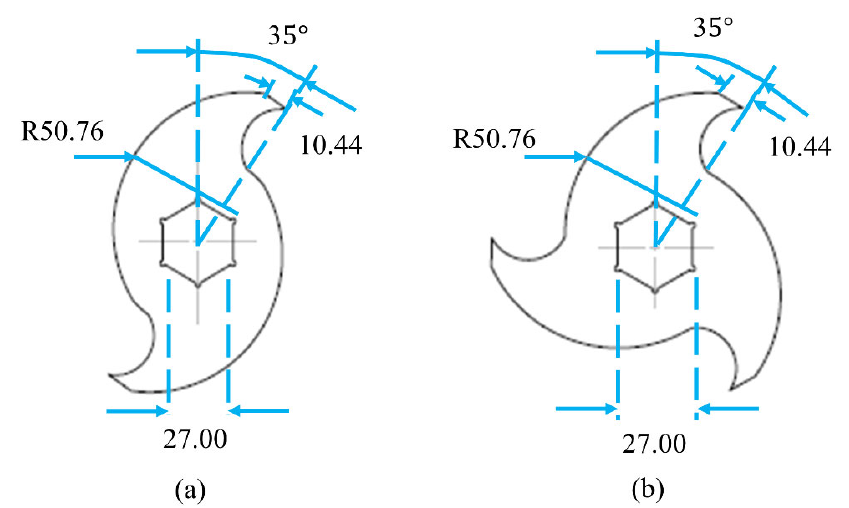
Figure 1. Geometrical design of the ( a ) double ‐ edge blade and ( b ) triple ‐ edge blade.